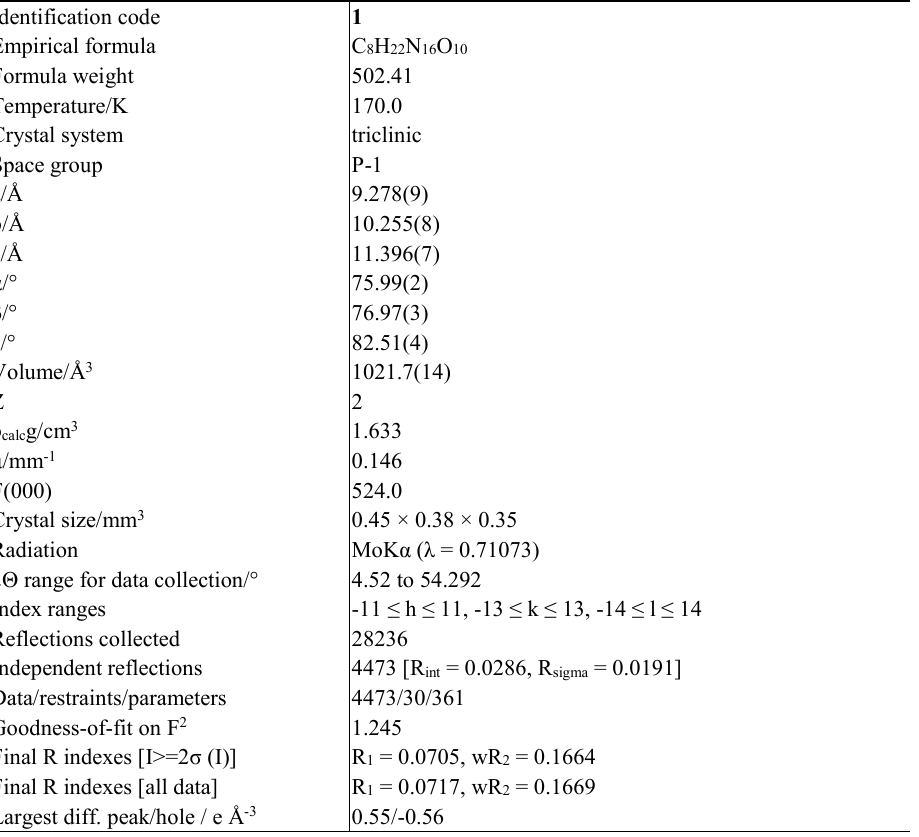
Table 1. Crystal data and structure refinement for 1